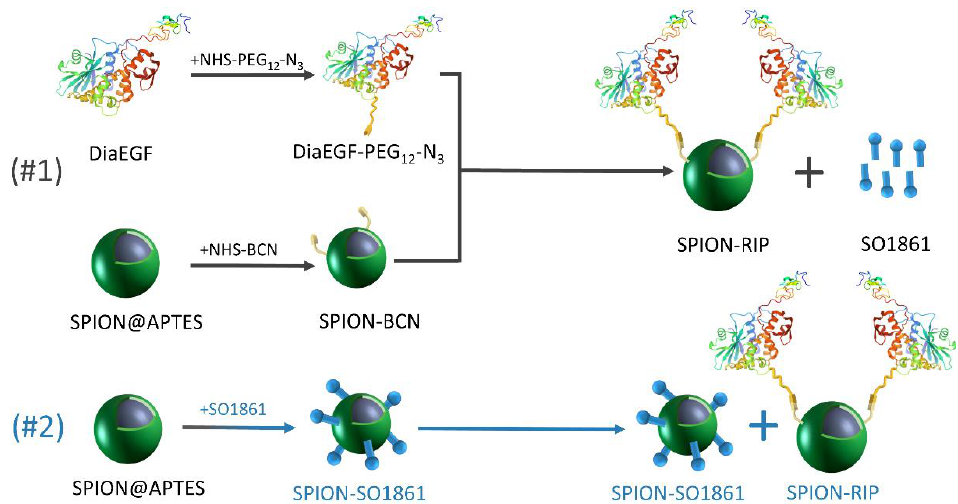
Figure 1. Schematic depiction of the synthesized particle systems including the individual experimental steps and the composition of the applied combinatorial approaches.